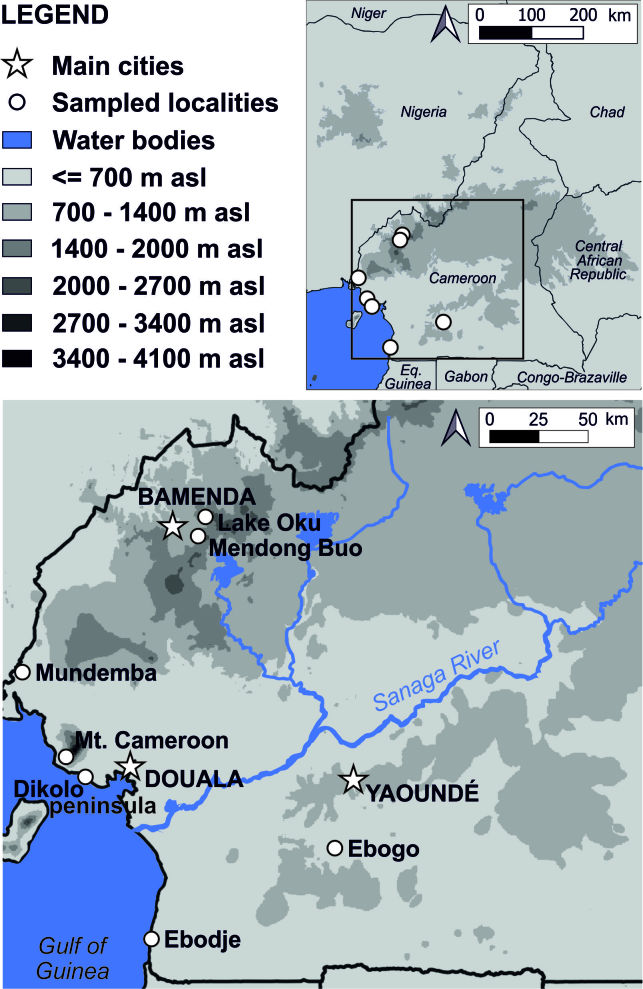
Map of Cameroon with the study sites and the Sanaga river considered as a border between the Guinean and Congolian biogeographic regions.